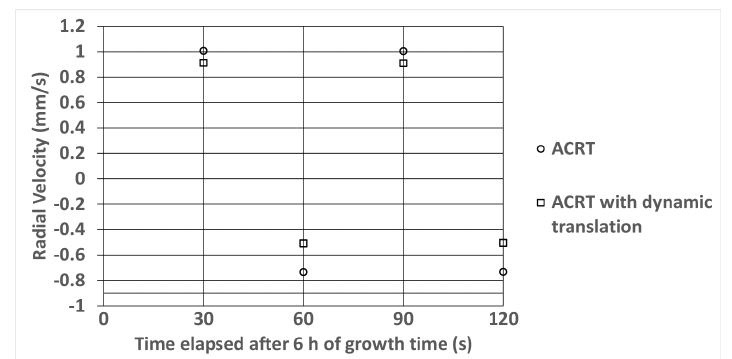
Figure 2. Maximum outward and inward radial velocities in the vicinity of the growth interface after 6 h of growth time.